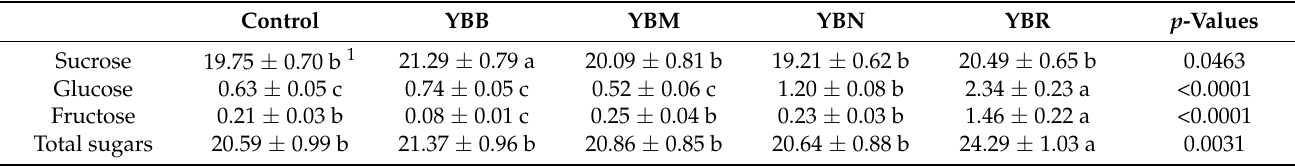
Table 5. The sugar content of yogurt bites, g · 100 g − 1